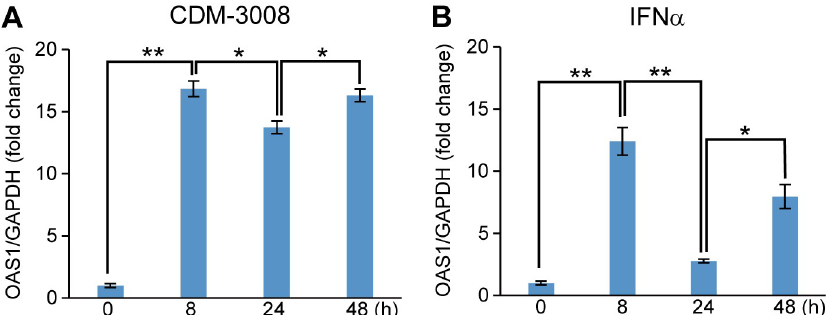
Fig 8. Time course of OAS1 expression after CDM-3008 or IFN α treatment. (A-B) OAS1 mRNA expression levels were compared after 0, 8, 24 and 48 h of CDM-3008 (A) and IFN α (B) treatment. The error bars in A, B indicate S.D. (n = 3). � , p < 0.05; �� , p < 0.01 (two-tailed t -test) in A, B.